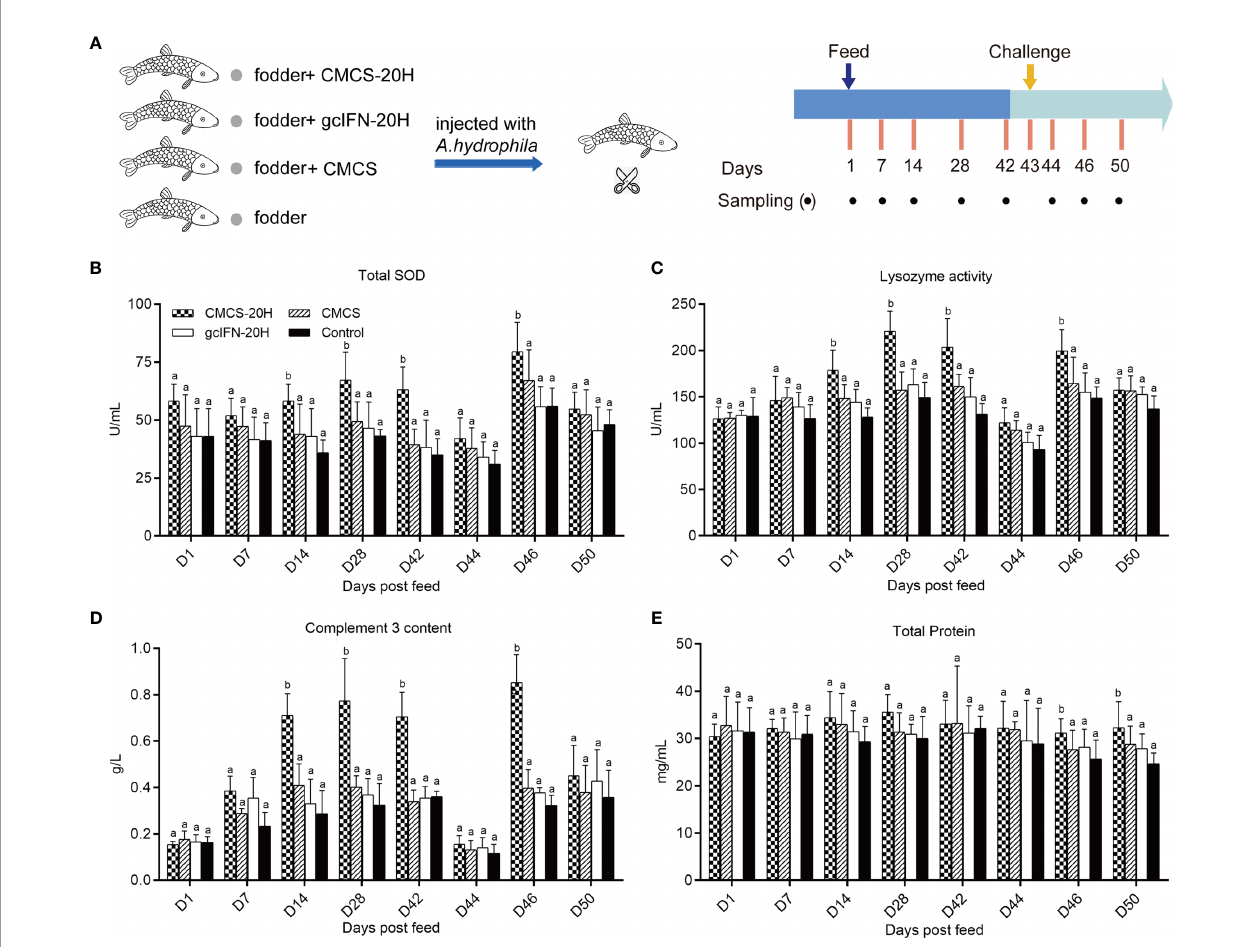
FIGURE 3 | Serum biochemical indexes of innate immunity assay. (A) Oral administration, challenge, and sampling schedule. Fish in each group ( n = 50) were feed with CMCS-20H+fodder, gcIFN-20H+fodder, CMCS+fodder, and fodder alone (control) and challenged with 100 µl A. hydrophila (2 × 10 5 CFU/ml) on D43. (B) The assay of total superoxide dismutase (TSOD) activity. (C) The assay of lysozyme activity. (D) The assay of complement 3 content. (E) The assay of total protein content. Serum biochemical indexes were determined by the corresponding speci fi c commercial kits (Nanjing Jiancheng Bioengineering Institute, Nanjing, China). Data are presented as means ± SD ( n = 4). Different lowercase letters in each group (a and b) denote signi fi cant variations suggested by the Kruskal-Wallis statistics followed by the Dunn ’ s multiple comparison (p <